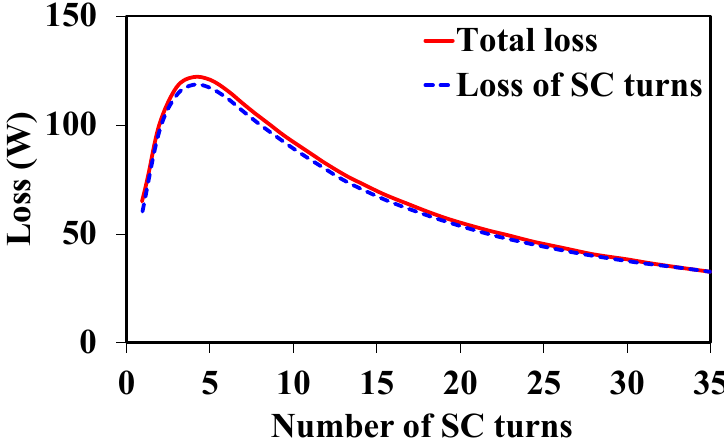
Figure 7. Loss of SC turns and healthy turns in one slot.